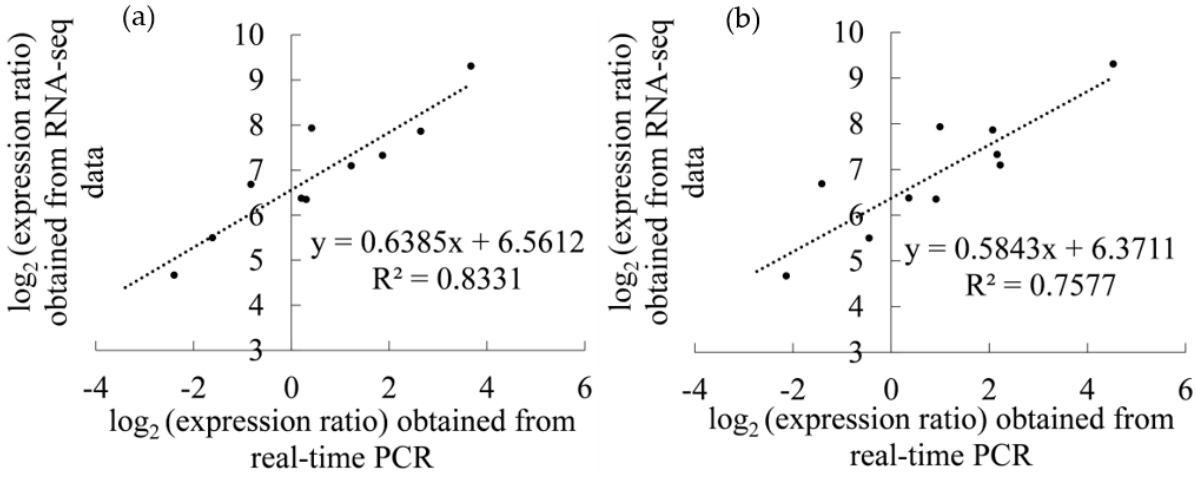
Figure 6. Correlation analysis between real-time PCR and transcriptome data: ( a ) 2020; ( b ) 2021.